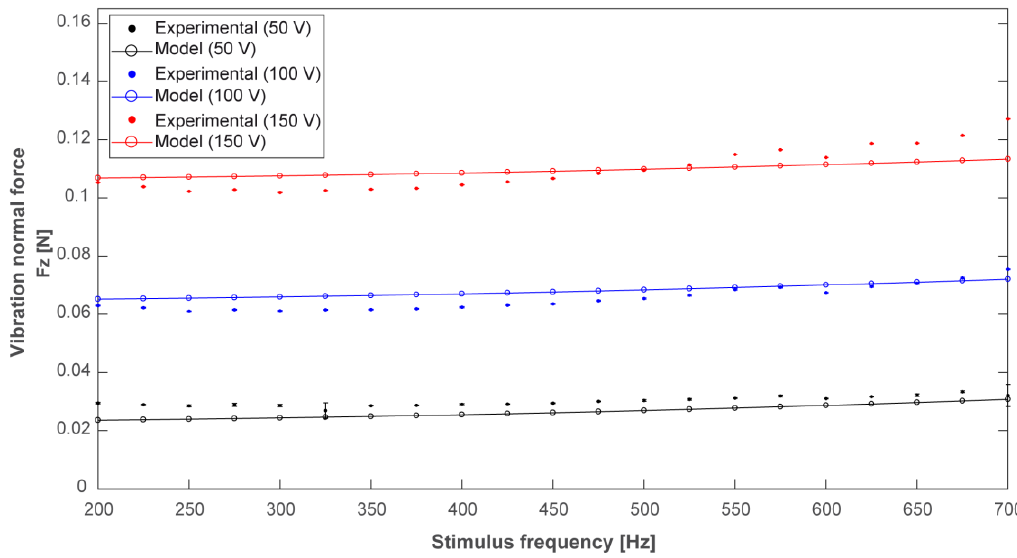
Figure 8. Vibrational component of the normal force exerted during transducers actuation. Predicted trend (solid lines with circles) and experimental measures (dots) of the normal force for the considered driving voltages. For each experimental point, the standard deviation is represented by vertical bars.